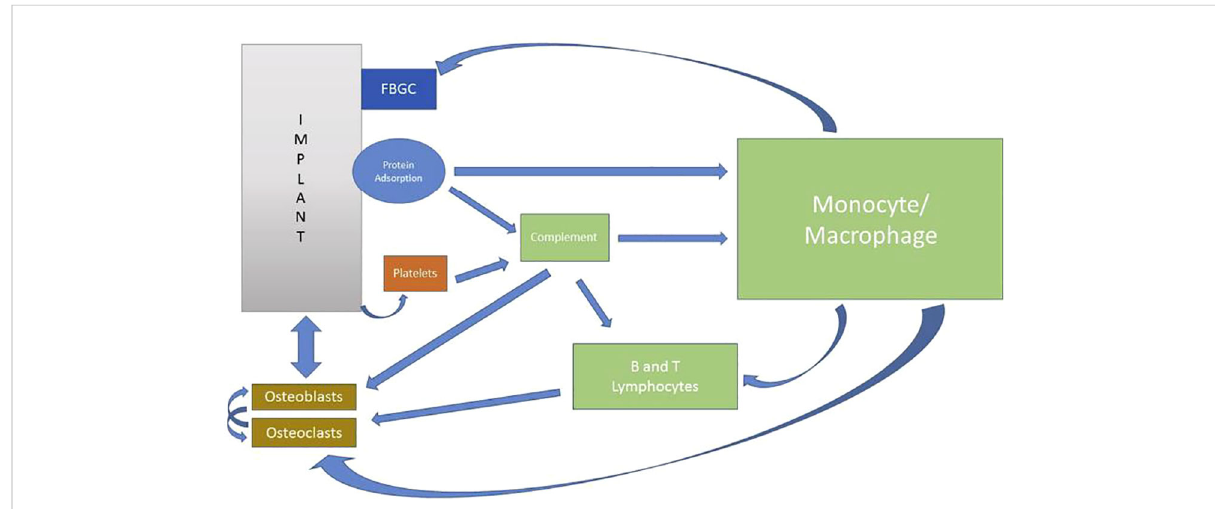
FIGURE 2 Hypothetical model for osseointegration dynamics. FBGC: foreign body giant cells. From Trindade, et al. Ref.